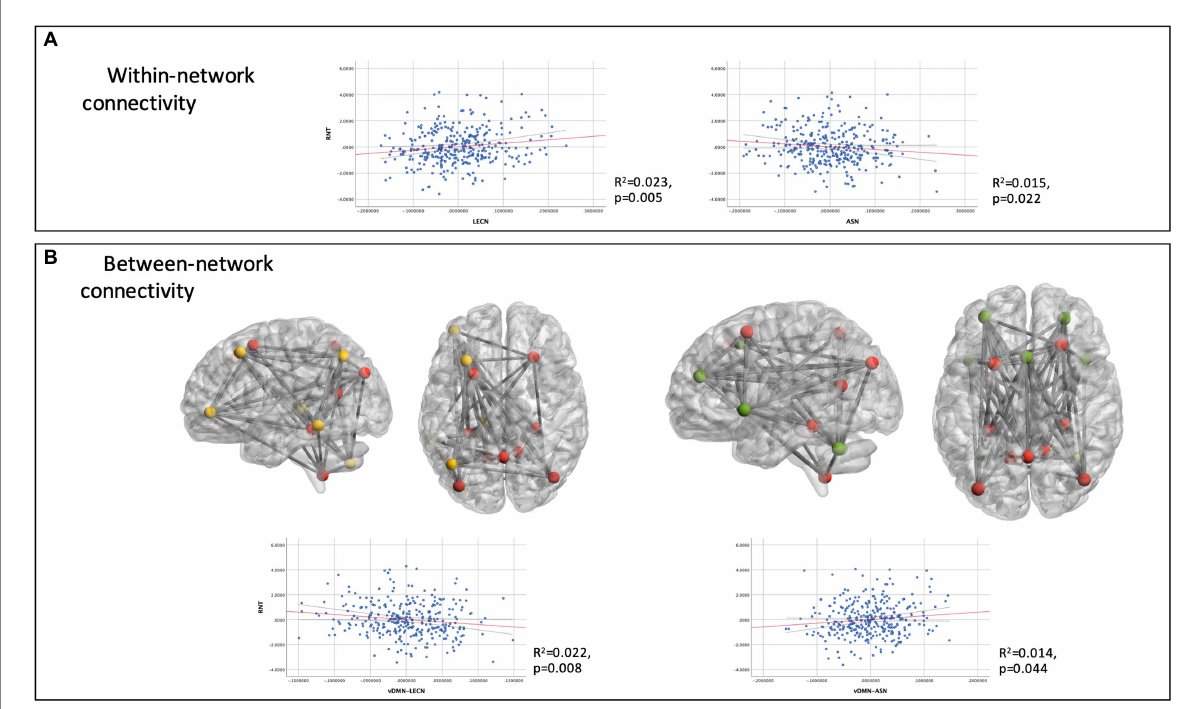
FIGURE 2 Partial regression plots for within-network connectivity (A) and between-network connectivity (B) associations with RNT. Dashed lines indicate the 99% confidence intervals for the regression line. For illustrative purposes, glass brains depict connectivity between functional region of interest (ROI) of vDMN (in red) with LECN (yellow) and ASN